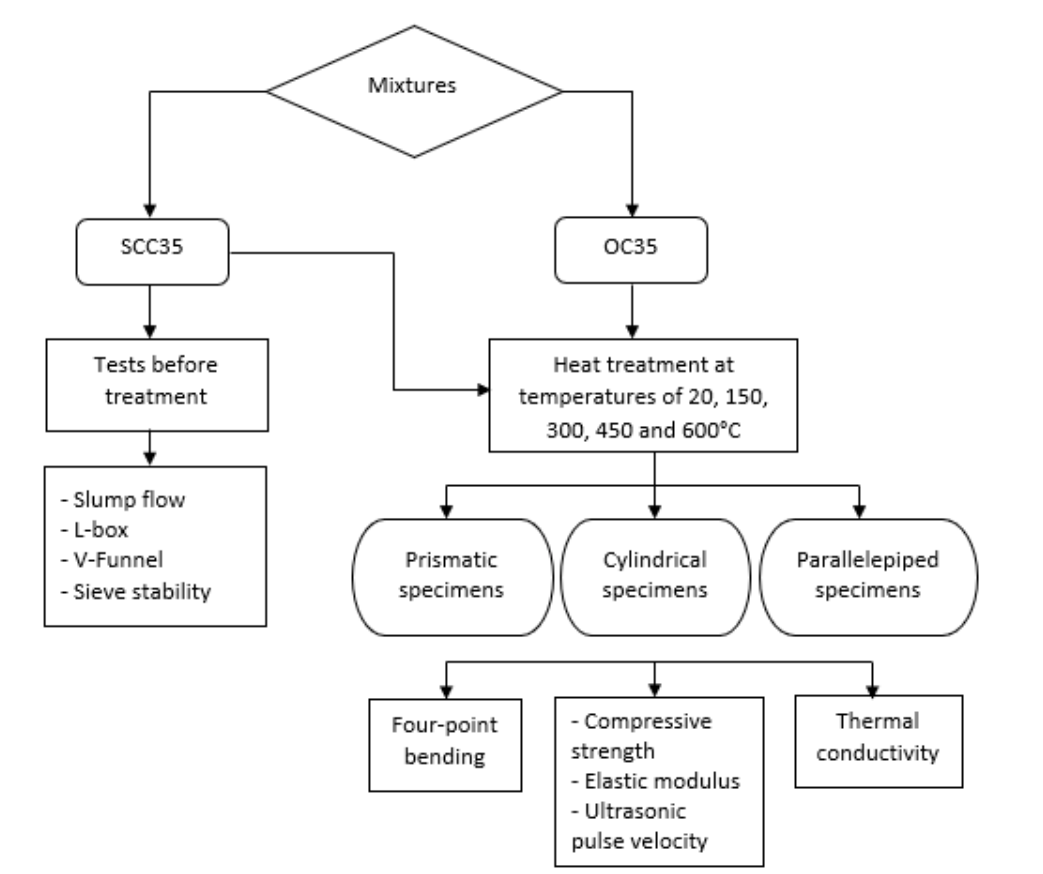
Figure 3. Flow chart for the experimental study representing the different tests that were carried out on the concrete specimens.